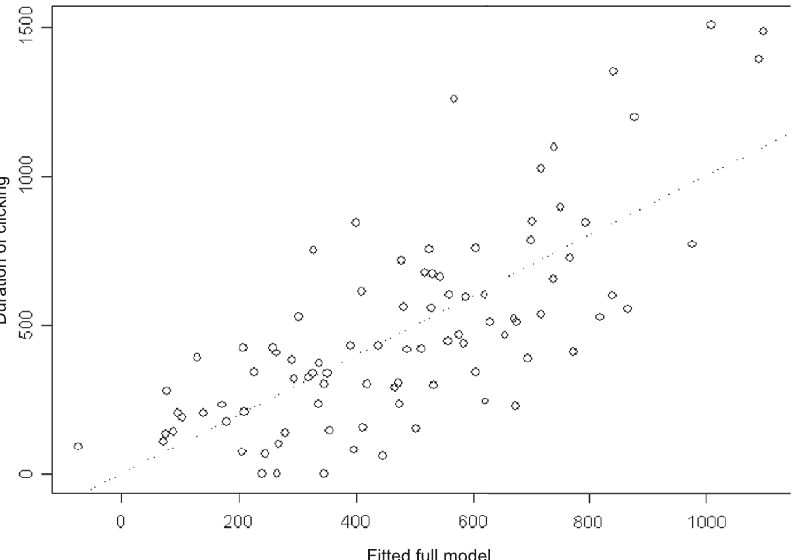
Figure 6. The full model foraging effort~f ( environment z prey ) with response plotted against fitted variables.